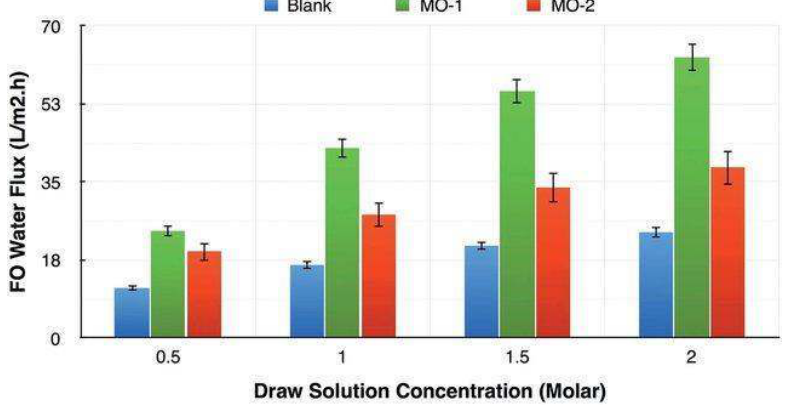
Figure 7. FO water flux of the membranes in atomic layer deposition (ALDS) mode and using different DS concentrations (T ¼ 25 C, feed ¼ DI water), error bars represent standard deviation over runs. Extracted from [73].